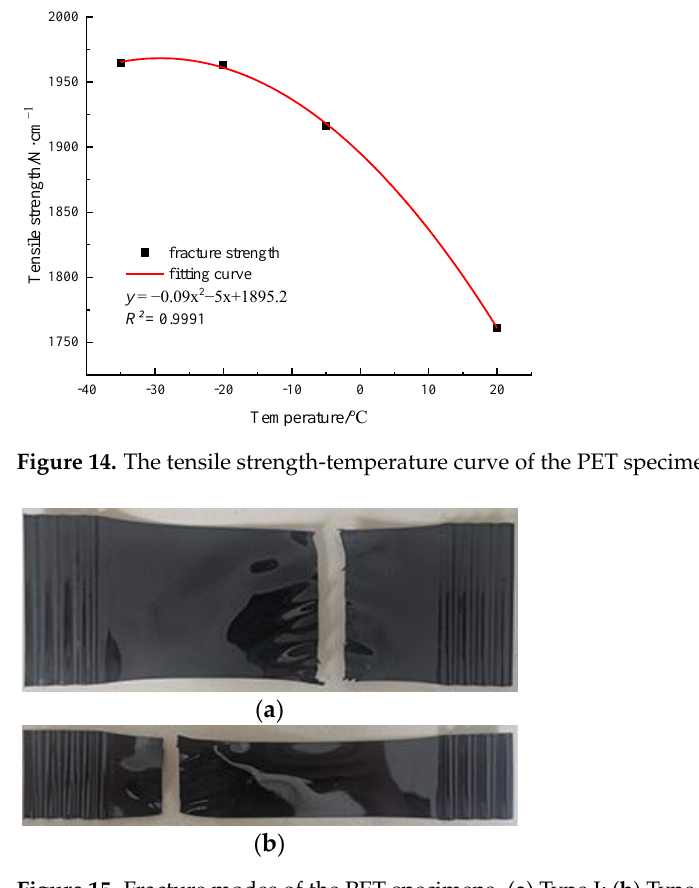
Figure 15. Fracture modes of the PET specimens. ( a ) Type I; ( b ) Type II.